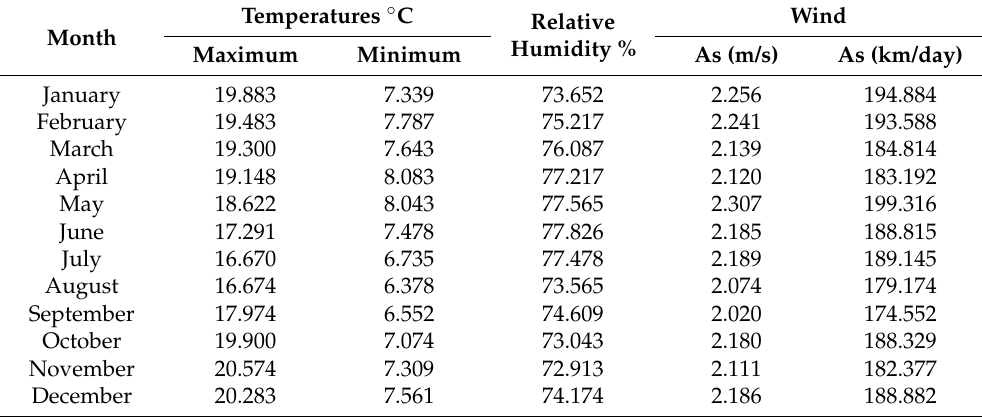
Table 2. Querochaca UTA station data, 22 years’ time